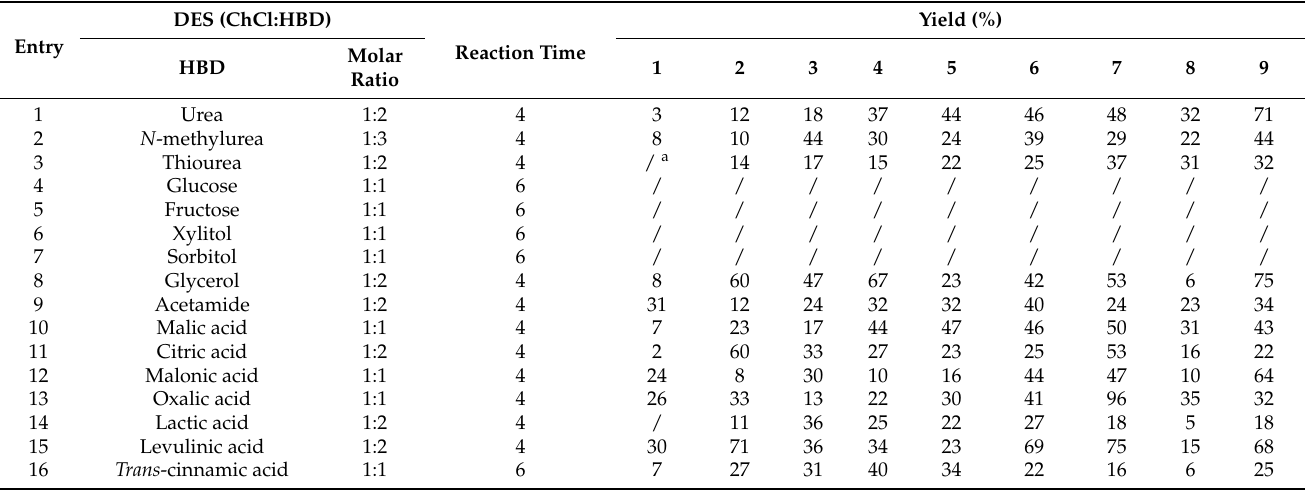
Table 2. Yields ( % ) of the conventional method for the synthesis of isonicotinamide quaternary salts ( 1 – 9 ) over 4–6 h at a temperature of 80 ◦